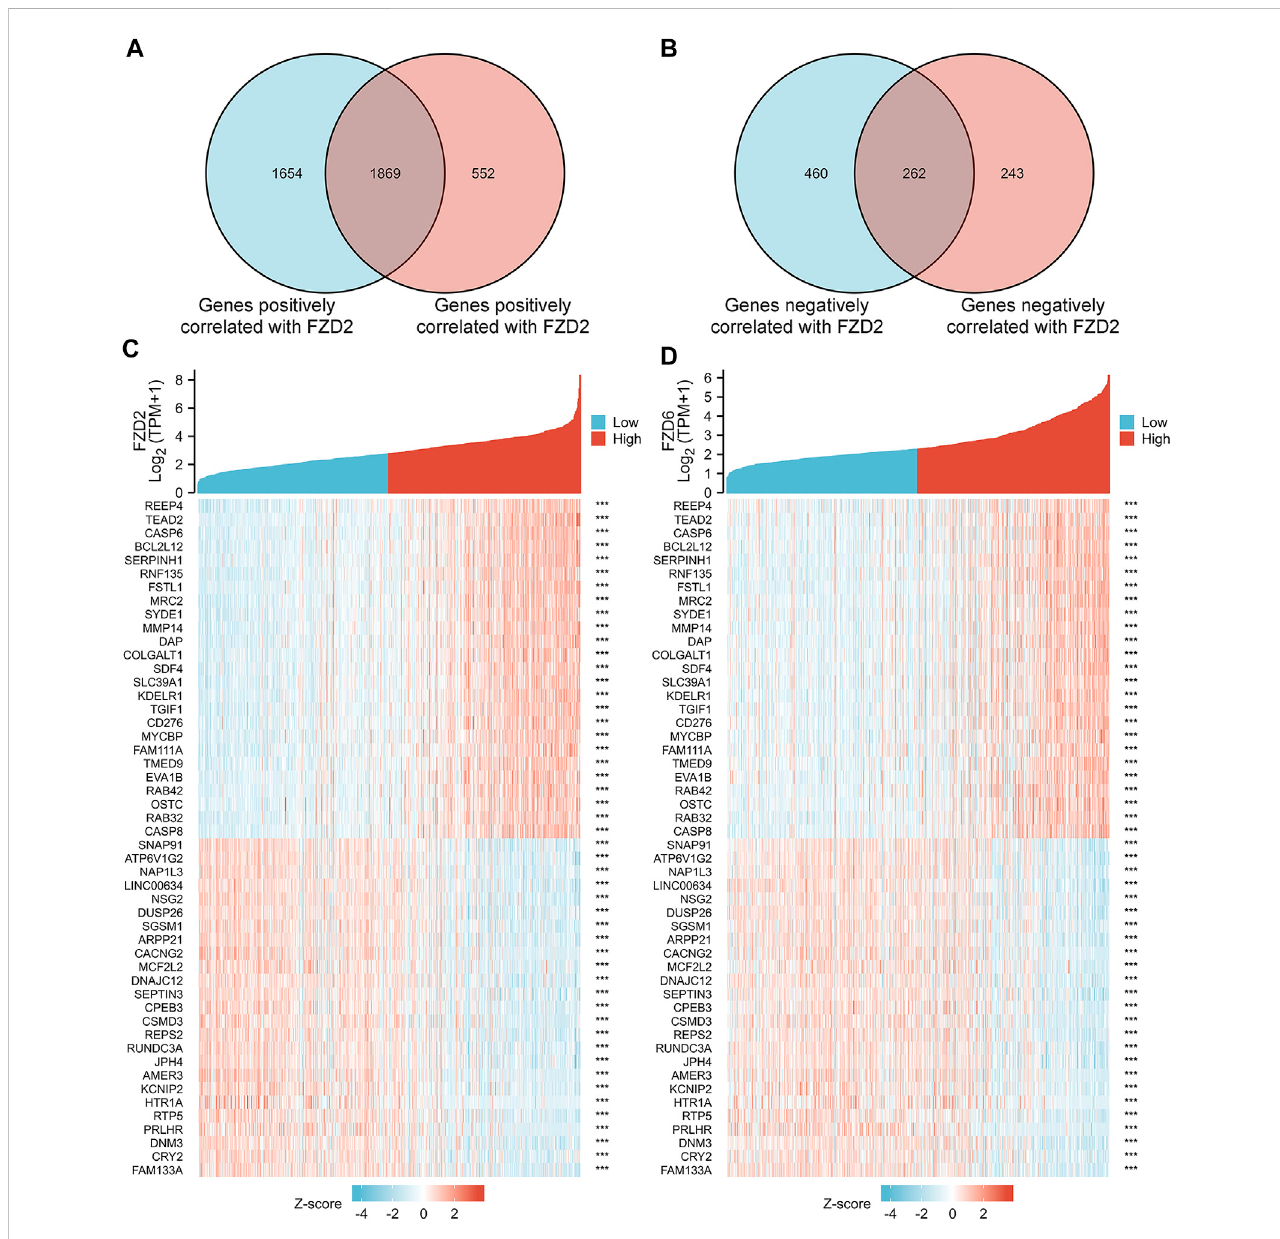
FIGURE 6 (A,B) Gene correlation analysis of FZD2 and FZD6 in Venn diagrams. (C,D) The top 25 genes positively or negatively correlated with FZD2 and FZD6